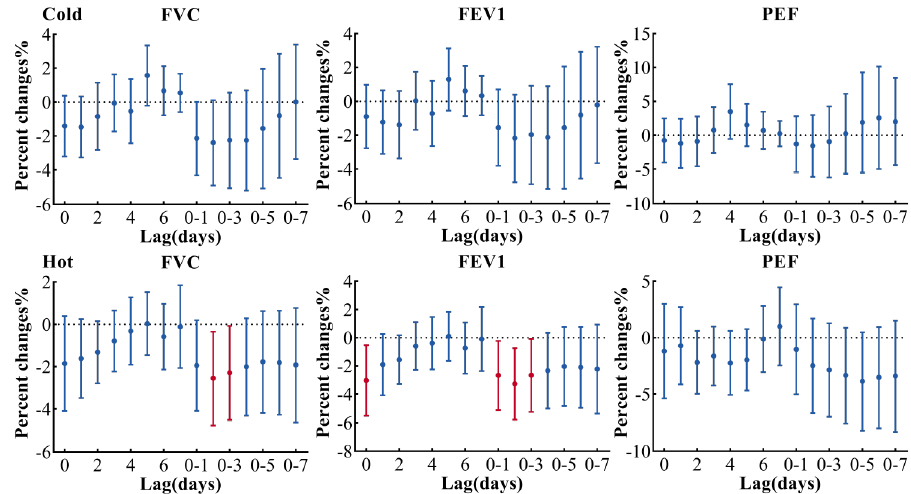
Figure 6. Association between lung function and PM 2.5 in a season-stratified multi-pollution model (adjusted PM 2.5 + SO 2 + O 3 ). Cold season refers to the period of November to March, and hot season means May to September [20]. Estimates are adjusted for questionnaire information, relative humidity, temperature, age, BMI, sex, holiday, day of week and times of the measurement. FVC, forced vital capacity; FEV1, forced expiratory volume in 1 s; PEF, peak expiratory